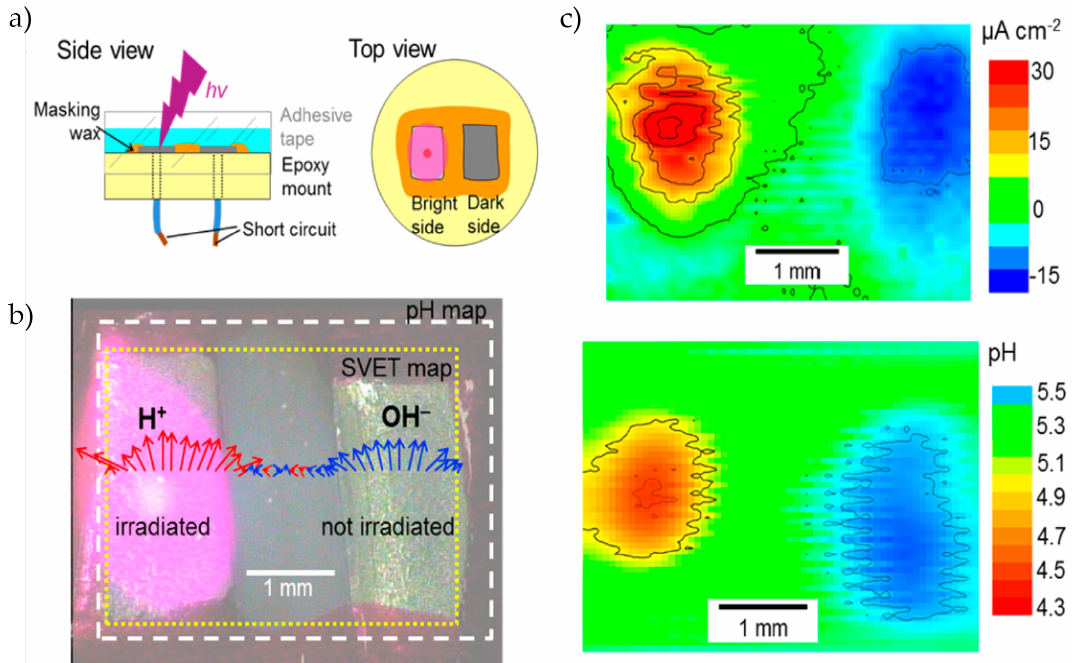
Figure 7. ( a ) Two separated titanium dioxide electrodes (n-type semiconductor) in one measurement chamber: Both electrodes are electrically shortened, while one electrode is illuminated from the top-side. ( b ) Due to the n-type behaviour, protons (H + ions) will be generated at the irradiated electrode, while the opposite reaction (OH − ions) will occur at the non-illuminated electrode. The arrows indicate the current density for the anodic (red) and cathodic (blue) reactions. ( c ) Current and pH maps of both electrode regions: Positive photocurrent occurs only at the illuminated area, while at the non-irradiated electrode, a negative current is present over the complete surface. The pH changes correlate with the current map. Reprinted (adapted) with permission from Maltaneva et al. [91] Copyright (2020) American Chemical